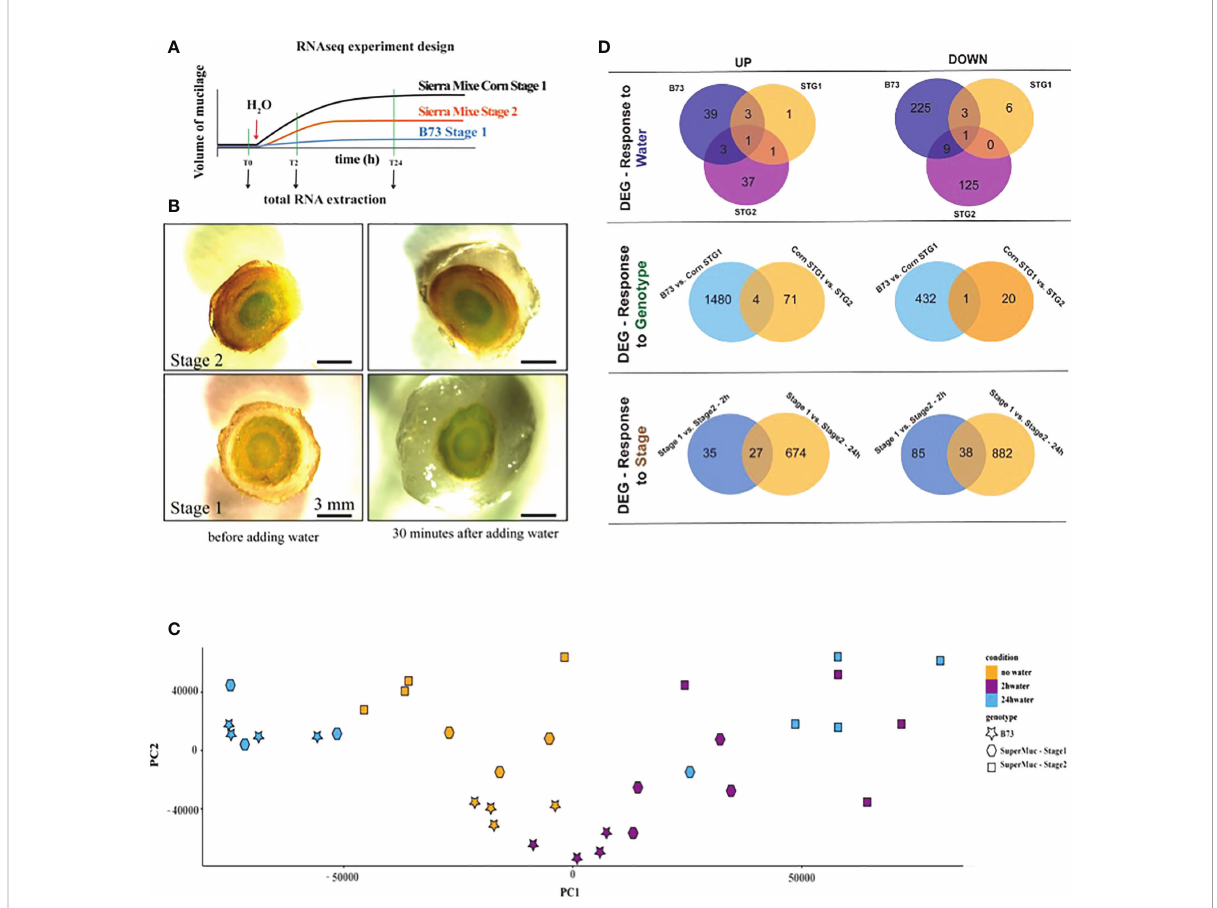
FIGURE 3 RNAseq analysis was performed to understand maize aerial root ’ s response during mucilage production. (A) RNAseq experiment schematic representation. B73 aerial roots produce tiny amounts of mucilage. Stage 1 roots from maize accession Sierra Mixe produces more mucilage than stage 2. (B) Transversal sections of aerial roots in stages 1 and 2 before contact with water and 30 minutes after contact with water. (C) Principal component (PC) analysis plot displaying all 35 samples along PC1 and PC2. (D) Differentially regulated genes (DEG) were selected to respond to water, genotype, and stage. The Venn diagram summarizes the overlap and unique UP or DOWN regulated genes in the various conditions; upper panel B73, Stage 1, and Stage 2 overlap referring to before and after adding water; middle panel, overlap between genes regulated in B73 and those regulated in Stage 2 and lower panel, the overlap of genes in Stage 1 and Stage 2 at 2 and 24 hours after exposure to water. p-value < 0.05 and log(10) fold-change >